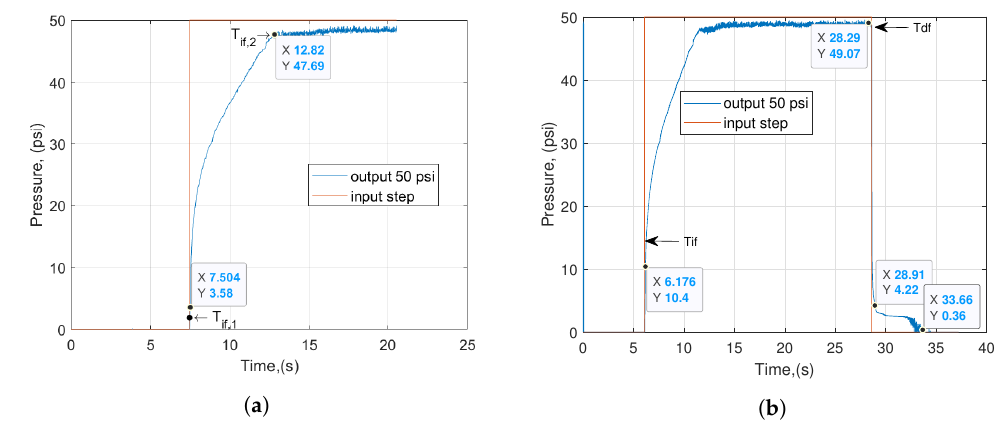
Figure 7. FISAs inflation-deflation time. ( a ) FISAs inflation process. ( b ) FISAs deflation process.